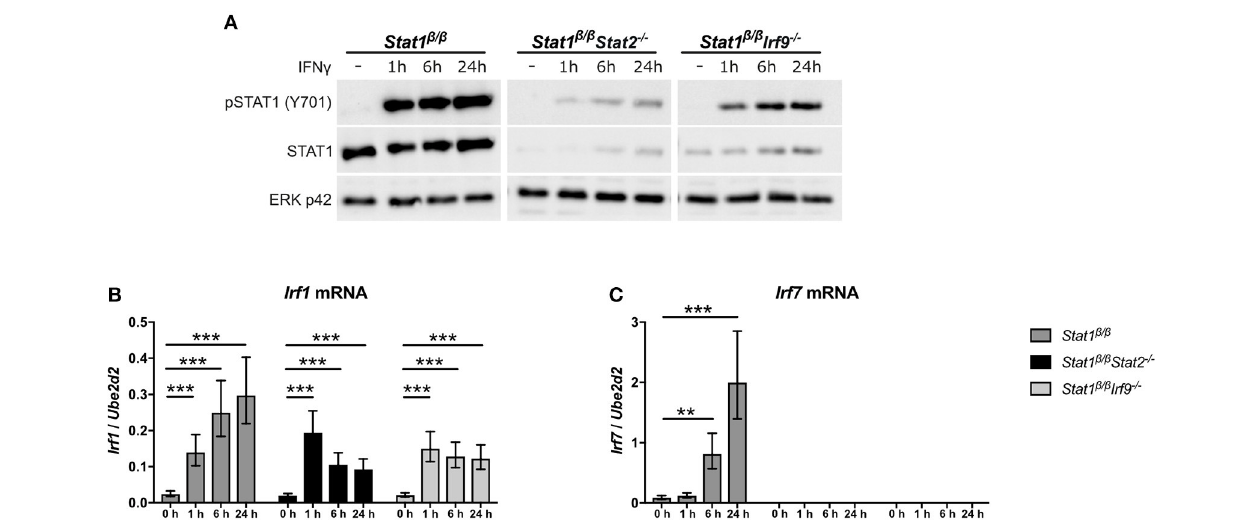
FIGURE 4 | IFN γ induced expression of Irf1 and Irf7 in Stat1 β/β cells in the absence of STAT2 or IRF9. BMDMs derived from Stat1 β/β , Stat1 β/β Stat2 − / − and Stat1 β/β Irf9 − / − mice were stimulated with IFN γ for the times indicated or left untreated (0h, -). (A) Protein was isolated and Tyr701-phosphorylated STAT1 (pSTAT1) and STAT1 protein levels determined by Western blotting. ERK p42 was used as loading control. One representative out of three independent experiments is shown. Original uncropped blots are shown in Supplementary Figure 2 . (B,C) Total RNA was isolated and Irf1 (B) and Irf7 (C) mRNA expression was determined by RT-qPCR. Data were normalized to Ube2d2 . Mean values ± SE from three (C) or four (B) independent experiments are shown. * P ≤ 0.05 , ** P ≤ 0.01 , *** P ≤ 0.001 . Significances are only indicated for the comparisons between